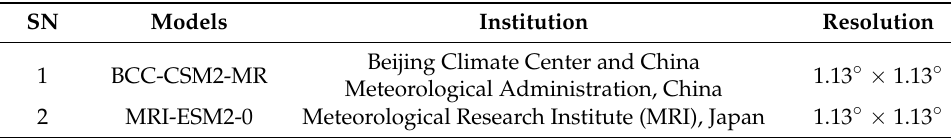
Table 2. Information of the CMIP6 climate models used in this